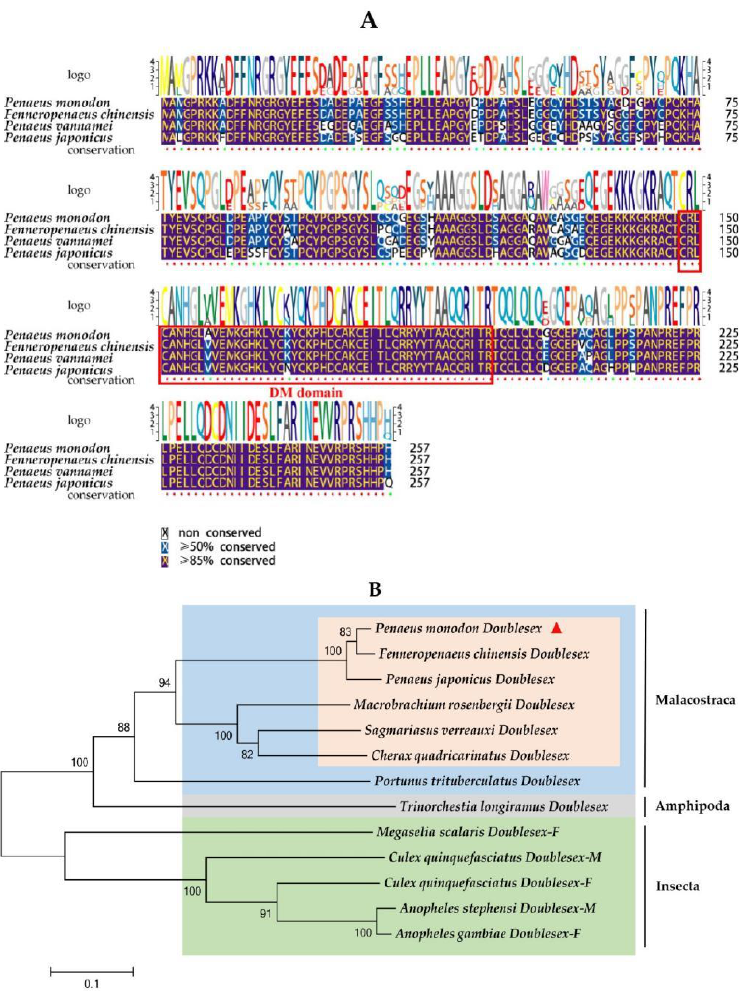
Figure 3. Multiple sequence alignment and phylogenetic analysis of the proteins of PmDsx and other species. ( A )The Dark purple areas are exactly the same, and the blue areas indicate that